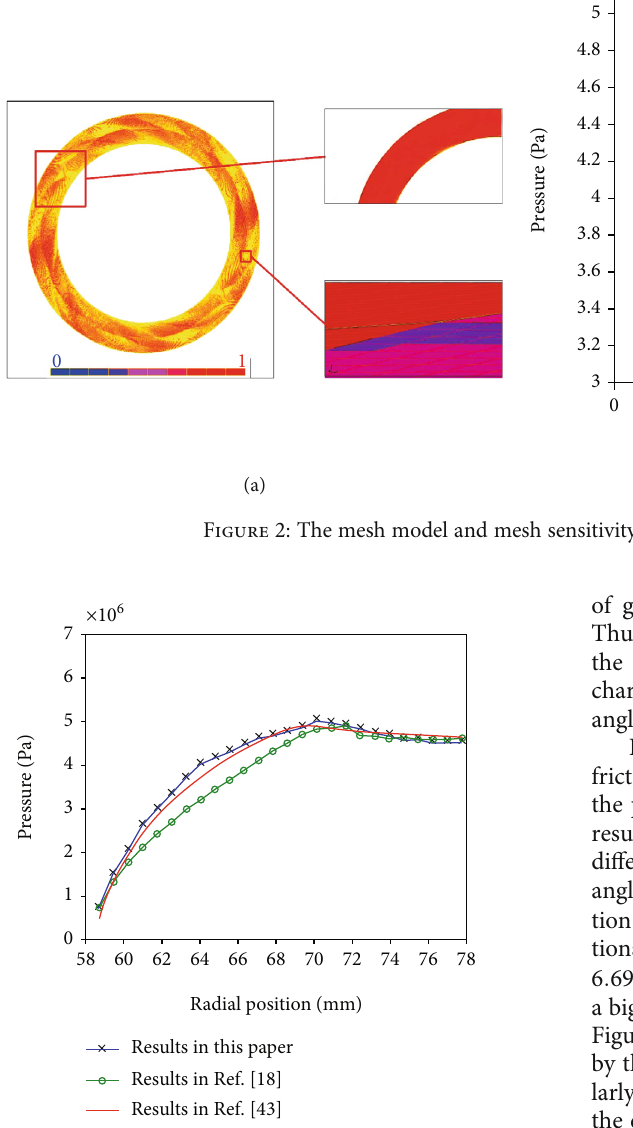
Figure 3: Comparison between the present model and experiment